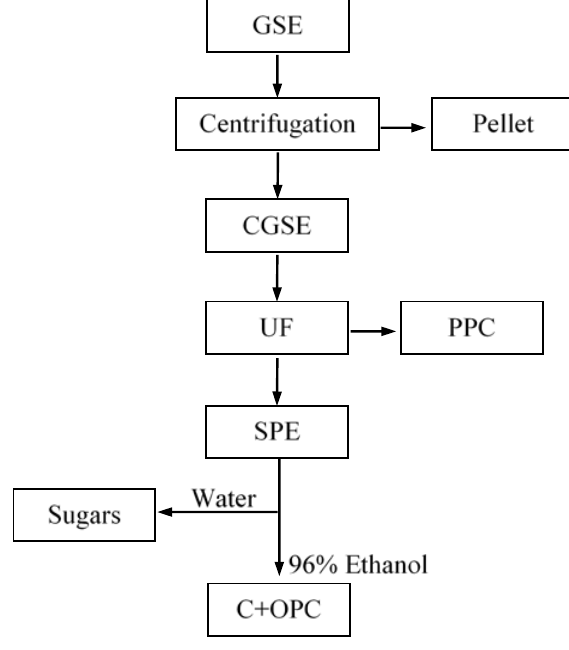
Figure 1. Flow chart of the purification pathway of oligomeric procyanidins from grape seed extract